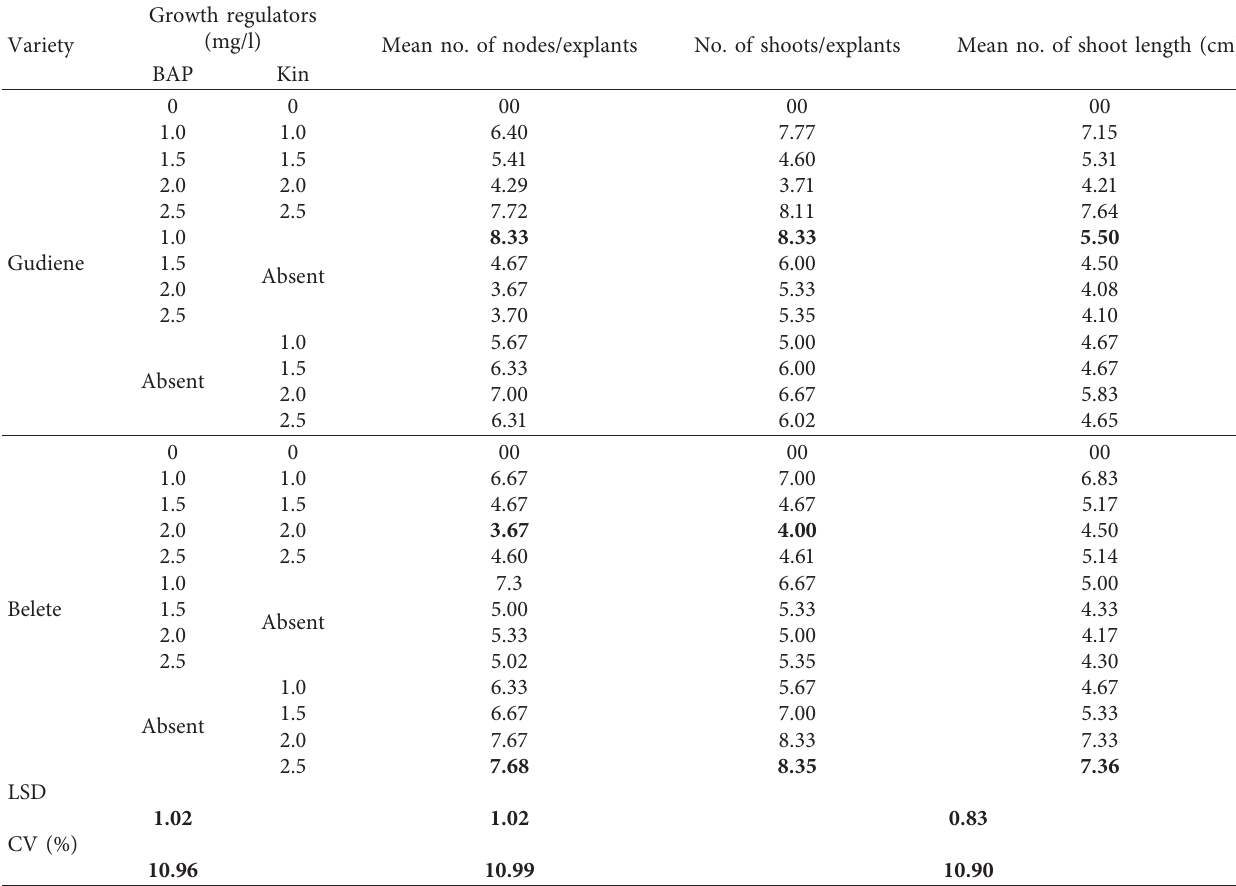
Table 2: The effect of various concentrations of BAP and Kinetin on in vitro shoot multiplication in potato Gudiene and Belete varieties.